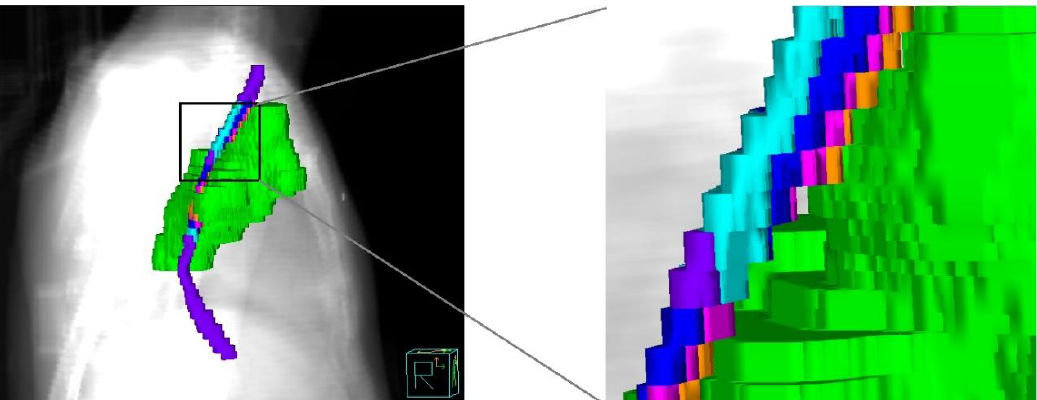
Figure 1. Segmental method of esophagus according to the isotropic distances in 3D directions to the planning target volume (PTV) geometry. PTV (green), involved esophagus (IE, white), abutting esophagus1 (AE1, orange), AE2 (light purple), AE3 (shaded blue), AE4 (blue), and AE5 (purple).